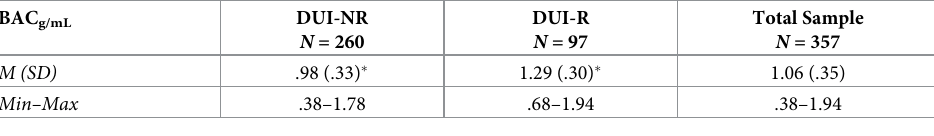
Table 2. Mean differences in BAC Between DUI-NR and DUI-R at first driving license